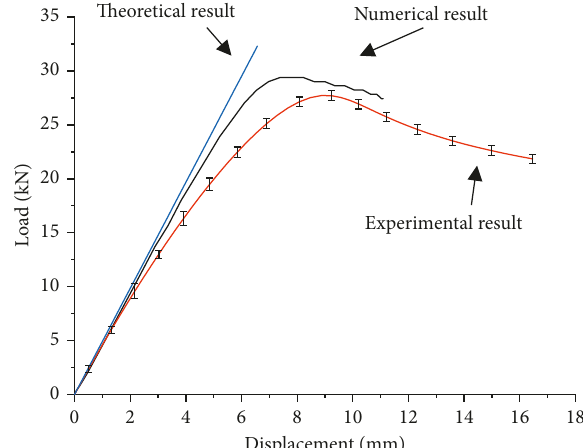
Figure 10: The load-deflection relation curves of the experimental (mean SD, n 5), numerical, and theoretical results. (cid:31) ±